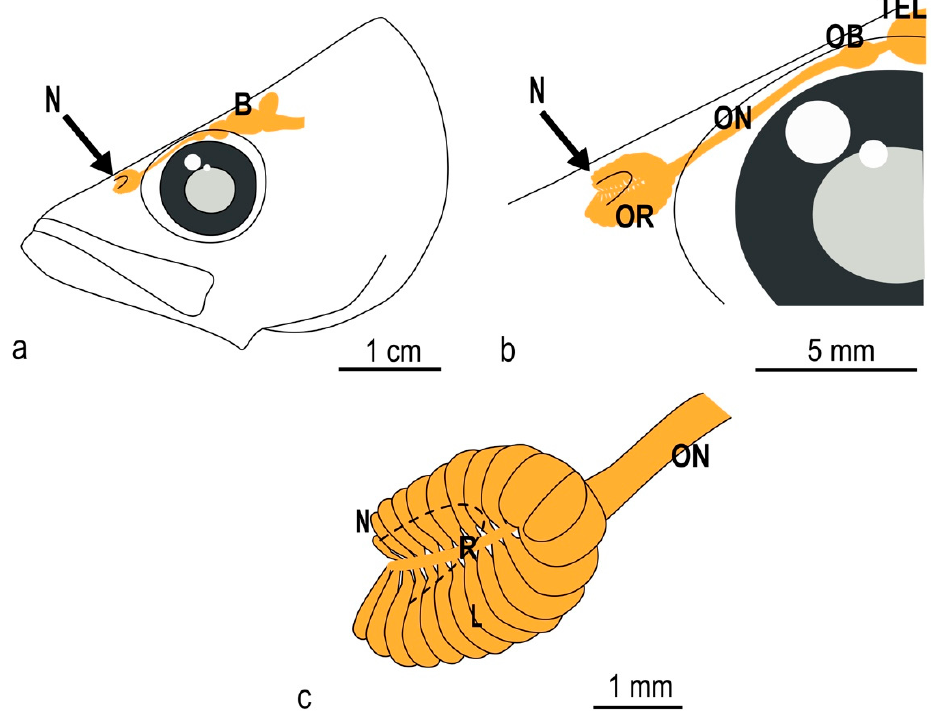
Figure 1. Schematic drawing of the adult P. antarcticum head with olfactory organ and brain. ( a ) Each nostril has a single, dorsally located opening. The position of the olfactory organ, nerve, bulb, and of the rest of the brain (in orange) is shown as if the head were transparent. ( b ) The nostril is open at the level of the anterior part of the rosette. The olfactory nerve runs along the orbit before entering the olfactory bulb. ( c ) The olfactory rosette has two unequal rows of lamellae; the shorter one is located medio-dorsally. B = brain; L = lamella; N = nostril; OB = olfactory bulb; ON = olfactory nerve; OR = olfactory rosette; R = raphe.